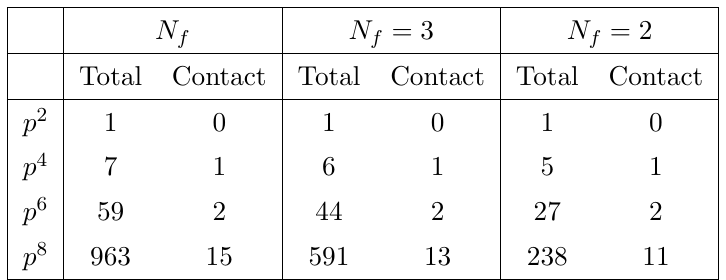
Table 4 . Number of monomials in the minimal basis for the case with no scalar or pseudoscalar external (cid:12)elds included. Also listed is how many of them are contact terms.